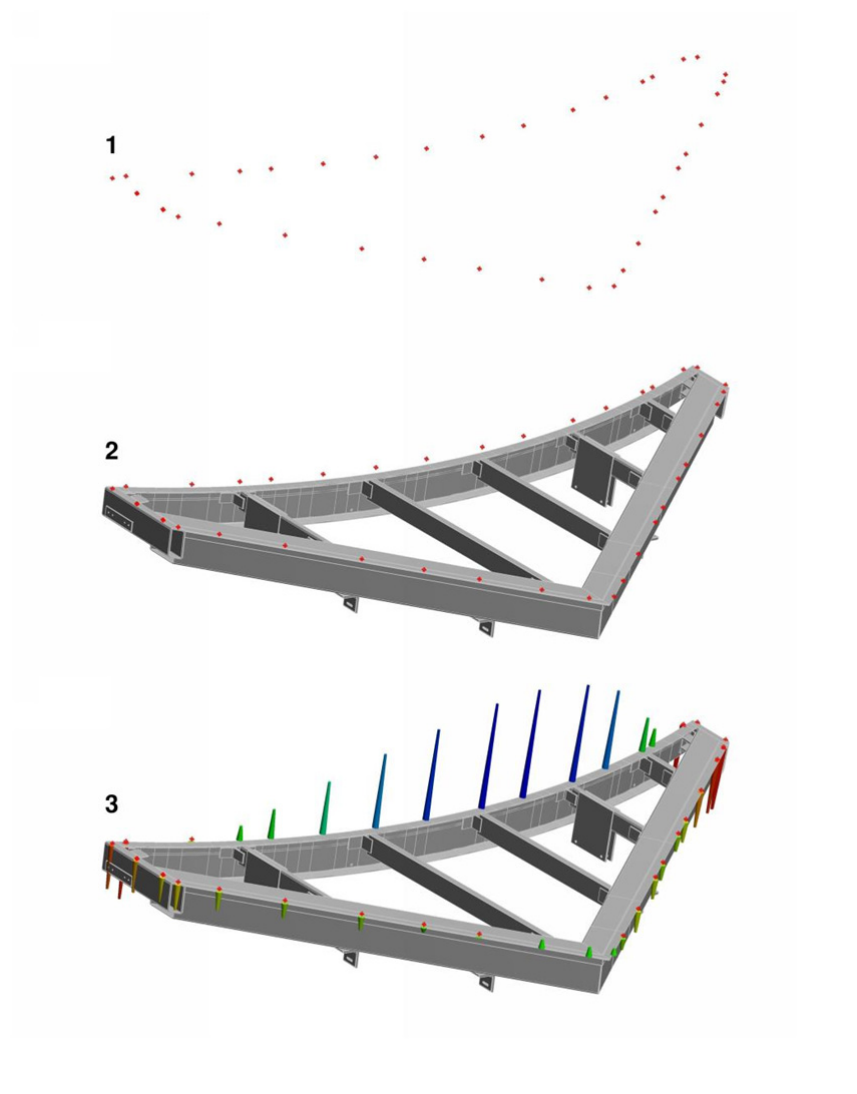
Fig. 6 Steel Truss Scan Utilizing Spatial Analyzing